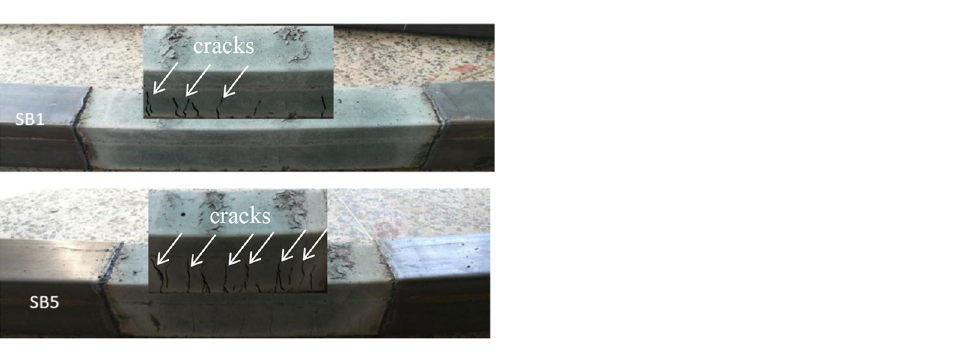
Figure 4. Typical failure modes of core